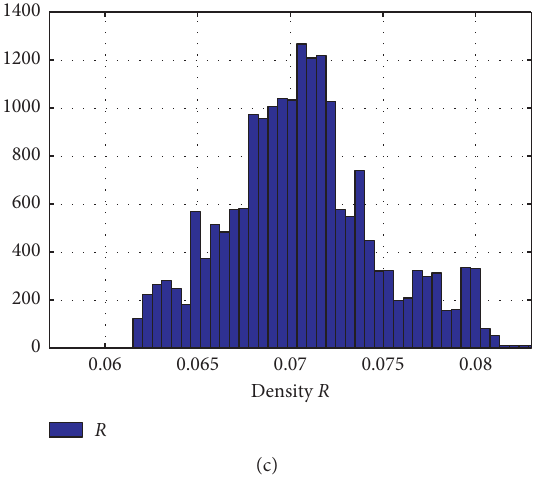
Figure 2: (a, b, and c) The distribution diagram of S, I , and R , respectively. σ